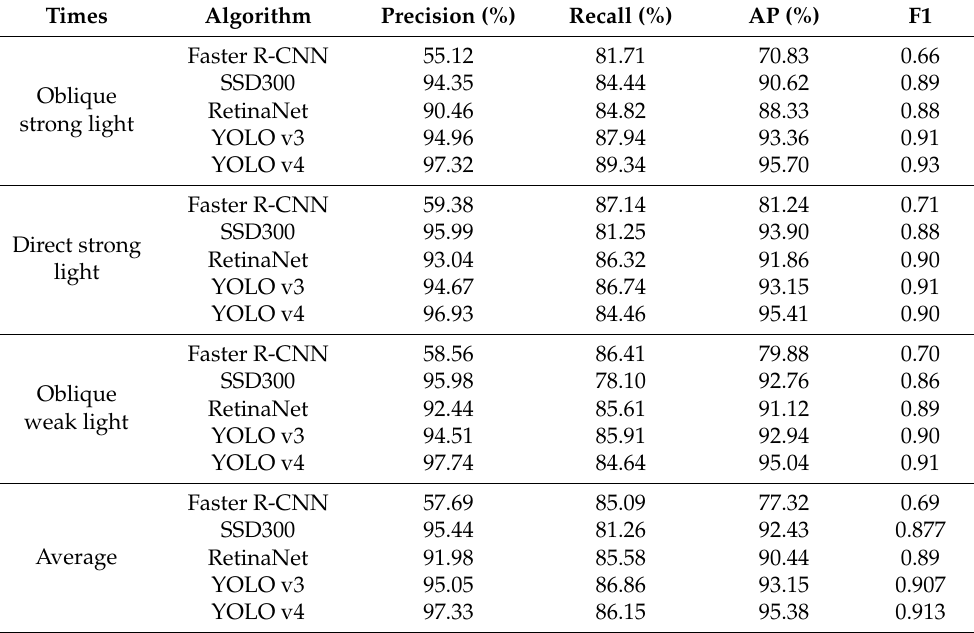
Table 6. Statistical detection results of five algorithms on stem nodes of sugarcane at different